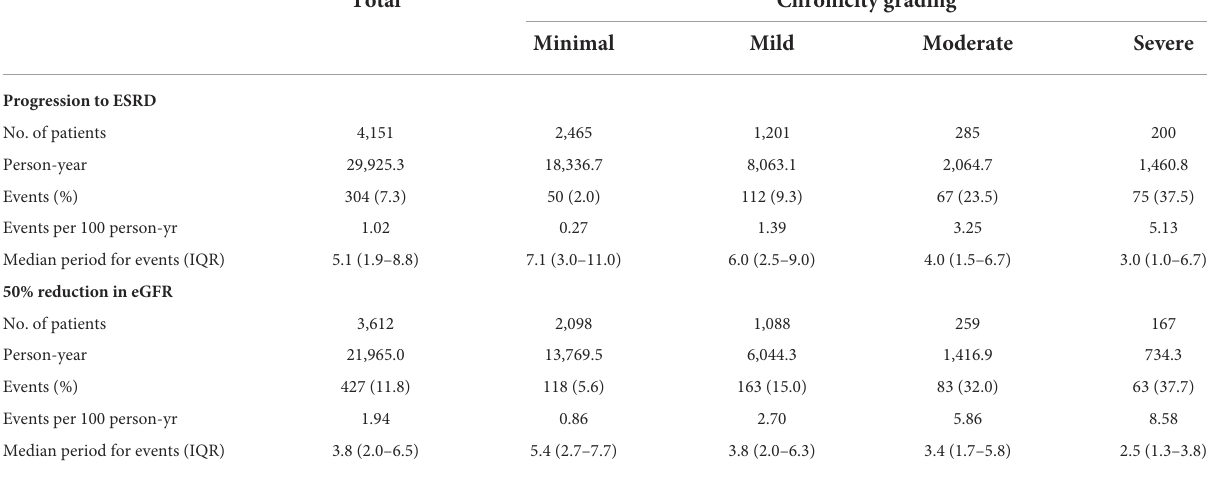
TABLE 2 Adverse outcome event rates among groups categorized by chronicity